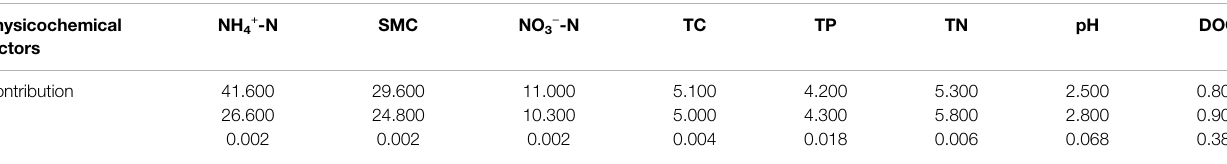
TABLE 4 | Importance and signi fi cation level of physicochemical